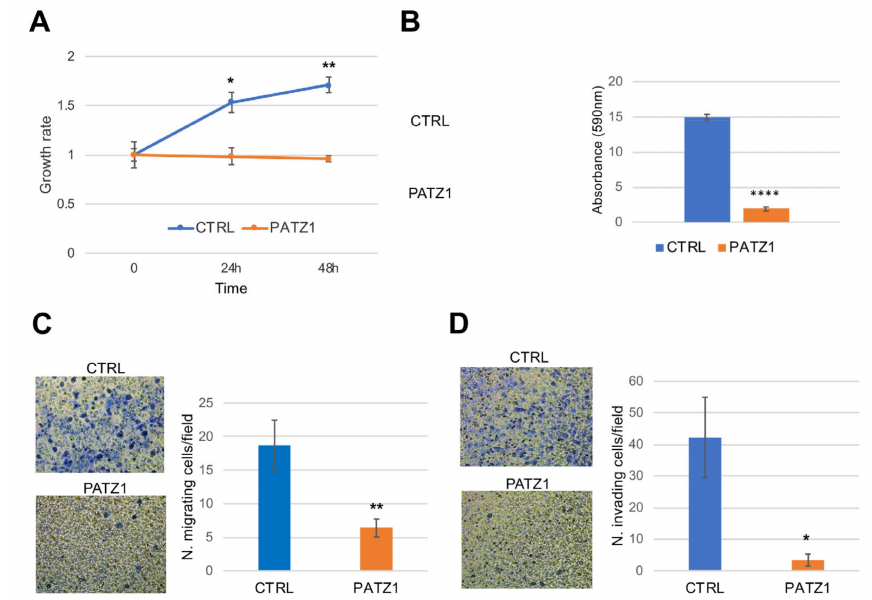
Figure 9. Functional analysis of PATZ1 overexpressing A549 NSCLC cells. The cells were transfected with a vector expressing PATZ1 cDNA or its corresponding empty vector. ( A ) Proliferation